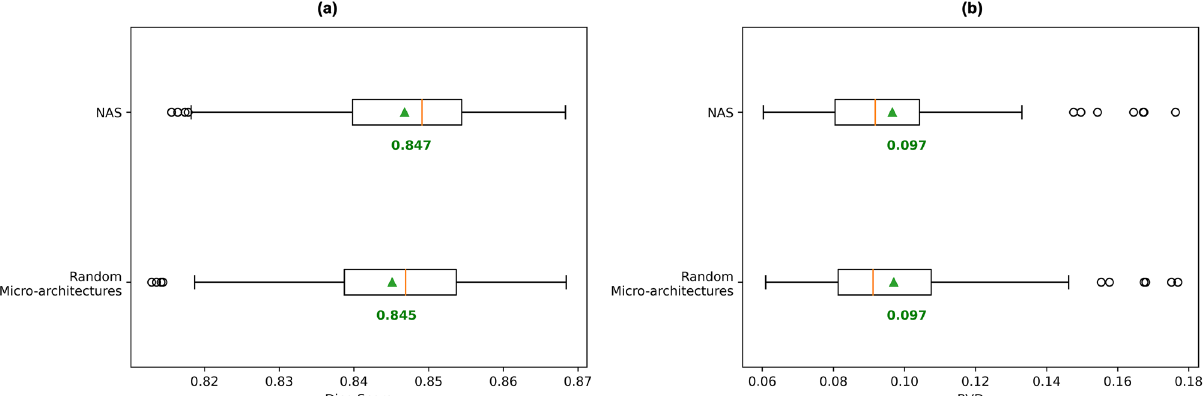
Figure 14. Comparison of networks with micro-architectures designed via NAS and models with randomised micro-architectures. Box plots are computed on the ( a ) Dice scores (higher is better), and ( b ) RVD values (lower is better), across all 105 subjects, where the score for a subject is the mean across its 72 tract scores. Mean across all subject scores is indicated by green triangle and text. Orange bar indicates median